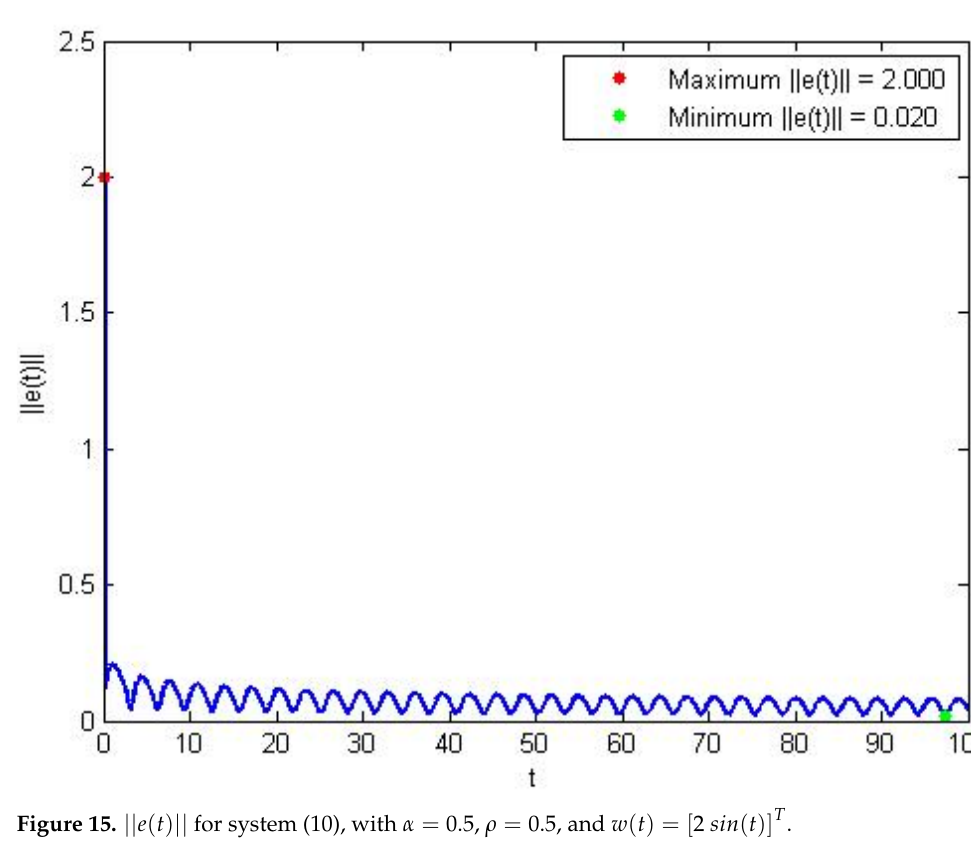
Figure 14. ‖𝜑(𝑡)‖ for system (10), with 𝛼 = 0.5 , 𝜌 = 1.5, and 𝑤(𝑡) = [2 𝑠𝑖𝑛(𝑡)] 𝑇 .